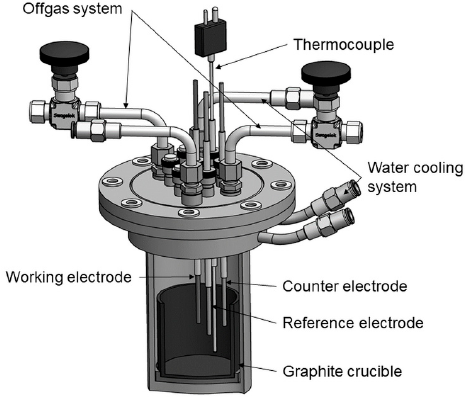
Figure 1. Experimental setup.